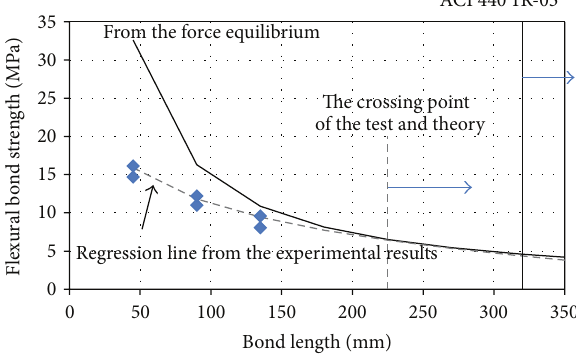
Figure6:Bondstrengthandbondlengthrelationshipbycalculation and test results.